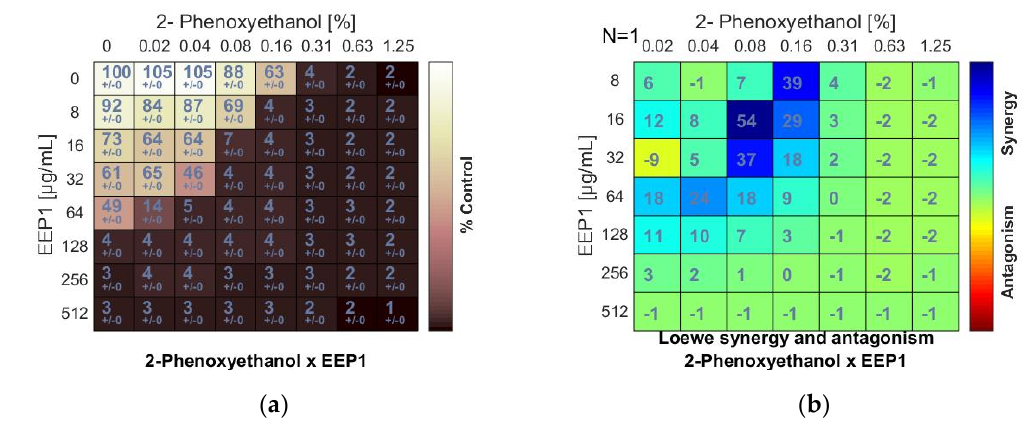
Figure 1. Synergistic effect between ethanolic extract of propolis and 2-phenoxyethanol against S. aureus ATCC 25923: ( a ) Checkerboard assay results showing the percentage growth inhibition compared with control; ( b ) Results showing synergy/antagonism calculations of synergy scores determined by the Combenefit software (the difference between the predicted additivity and the observed viability) for the Loewe model. A heat map represents the level of synergy (blue color) at each concentration. A positive score indicates synergy, a score of 0 is additive, and a negative score indicates antagonism (red color).